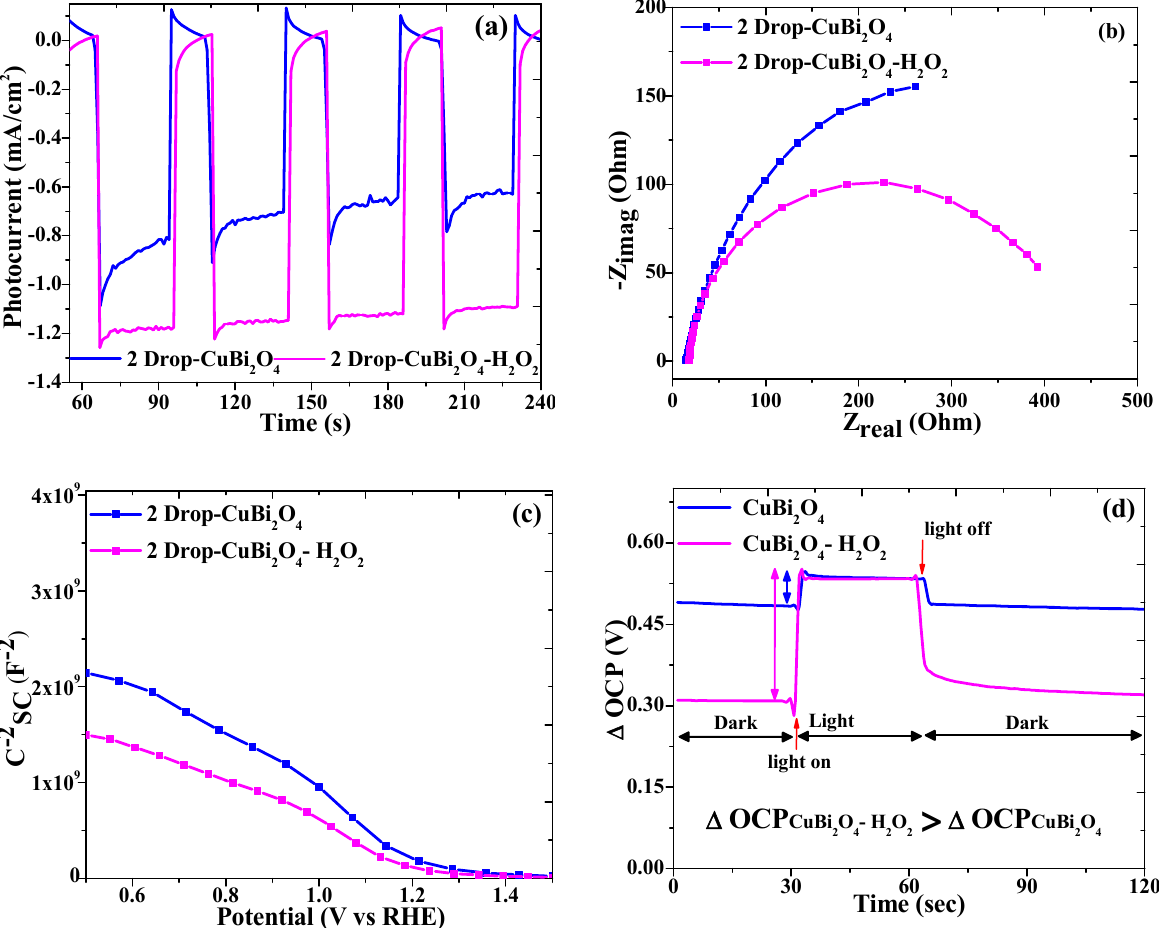
Figure 6. ( a ) Photocurrent response, ( b ) Nyquist, ( c ) Mott–Schottky plots, and ( d ) Open-circuit potential (OCP) measurements of the #2-CuBi 2 O 4 photocathodes with and without H 2 O 2 . Under 100 mW/cm 2 illumination, the electrolyte was a 0.5 M aqueous solution of Na 2 SO 4 .